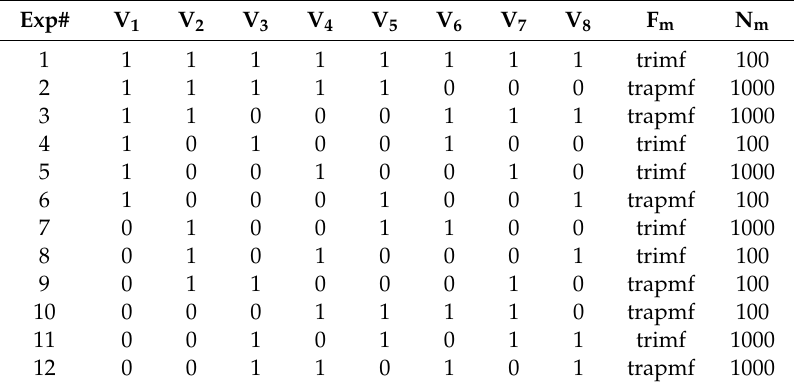
Table 2. Orthogonal array (L 12 ) for the feature selection.